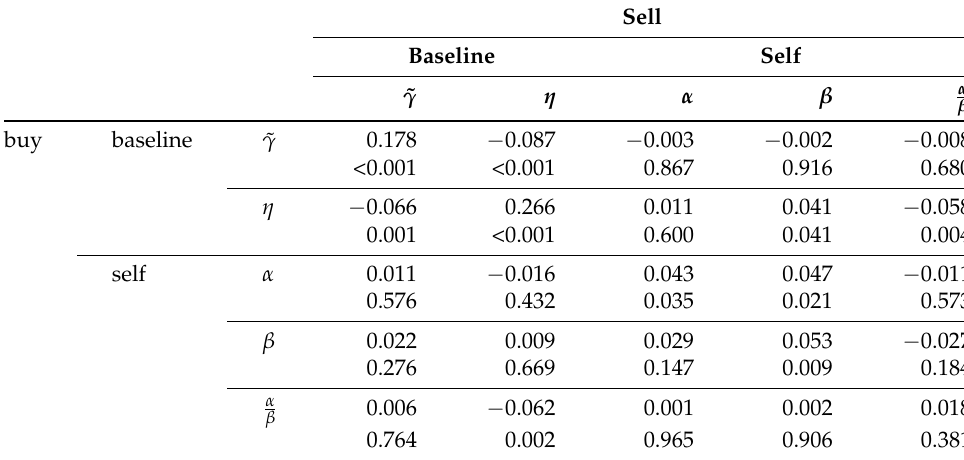
Sell Baseline Self ˜ γ